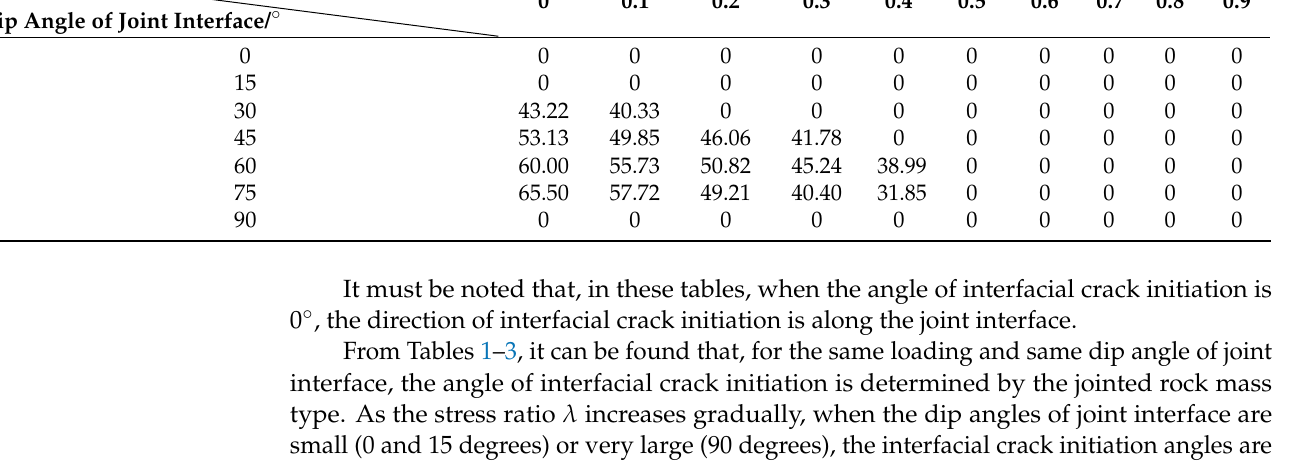
Dip Angle of Joint Interface/